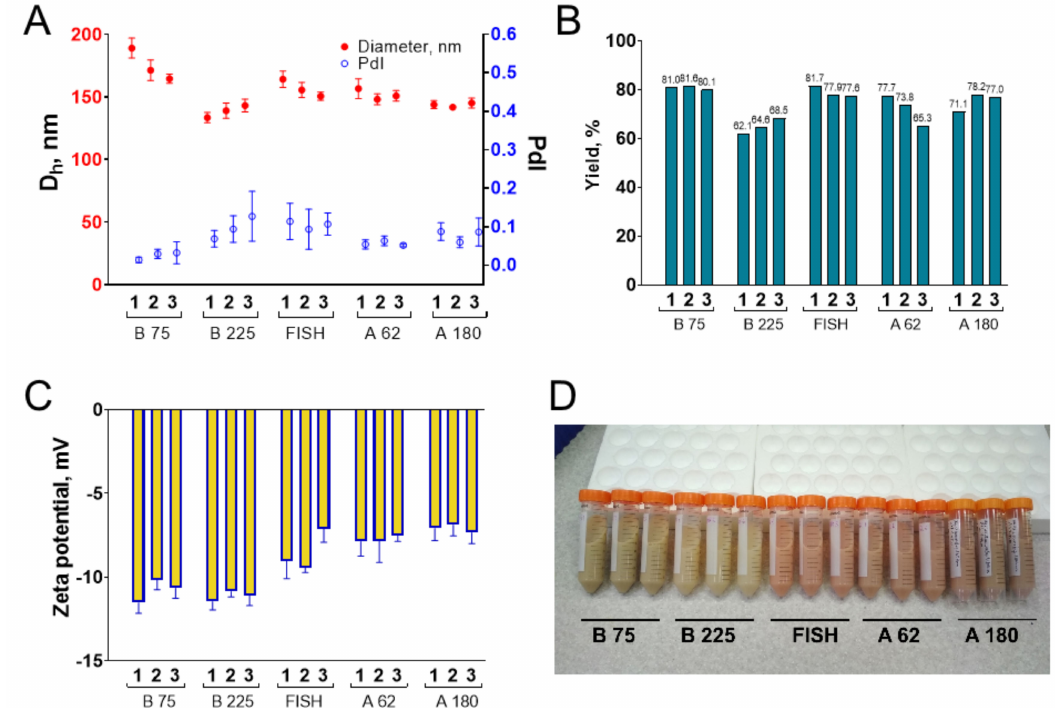
Figure 4. Properties of gelatin nanoparticles prepared from various gelatins in the hundreds-of-milligram scale: ( A ) size and polydispersity index; ( B ) yield; ( C ) zeta potential (at a pH 7); ( D ) the appearance of gelatin nanoparticle suspensions. Numbers 1, 2, and 3 denote the batch numbers. Dh—hydrodynamic diameter; PdI—polydispersity index. Mean values of three technical replicates are shown, mean ±